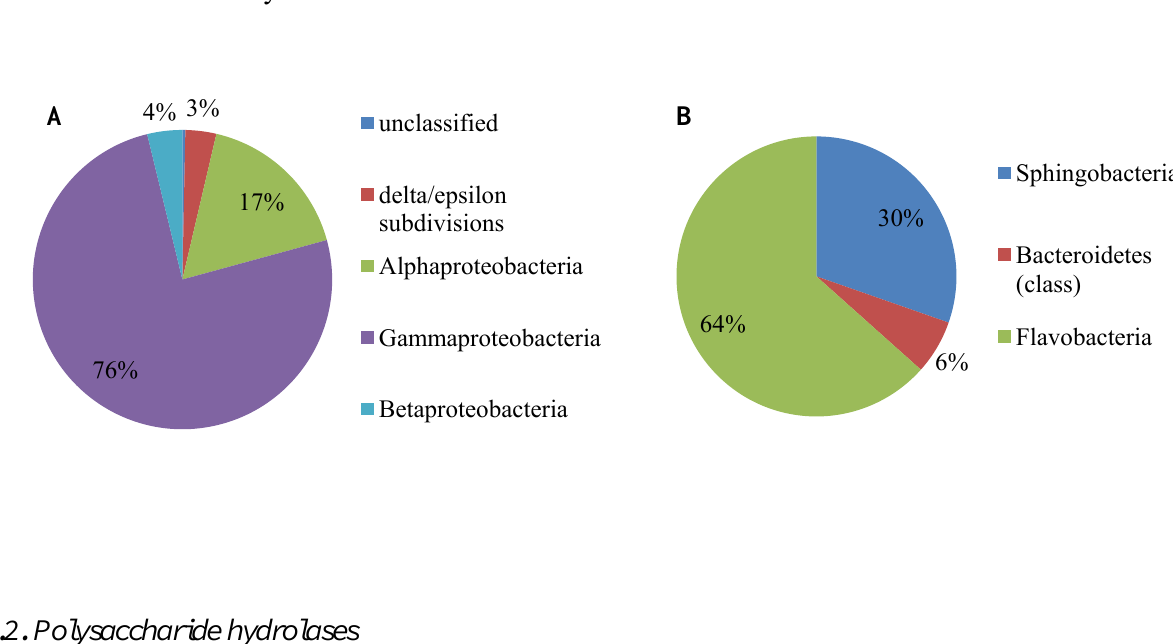
Figure 2. Taxonomic assignment of 13,312 sequence contigs matching Protein encoding genes (PEGs) of the Proteobacteria and the Bacteroidetes. The percentage of contigs matching PEGs assigned at the Class level using the SEED MG-RAST (Metagenome Rapid Annotation Using Subsystem Technology are shown for ( A ) Proteobacteria (8847; 61% of assignments to the Bacteria) and ( B ) Bacteroidetes (4465; 32% of assignments to Bacteria). Values are shown as percentages of the total contigs assigned to each class within the two